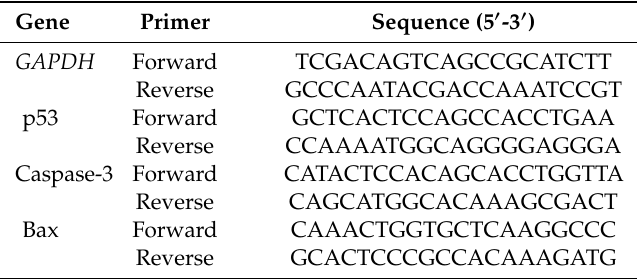
Table 3. Primers used in real-time PCR